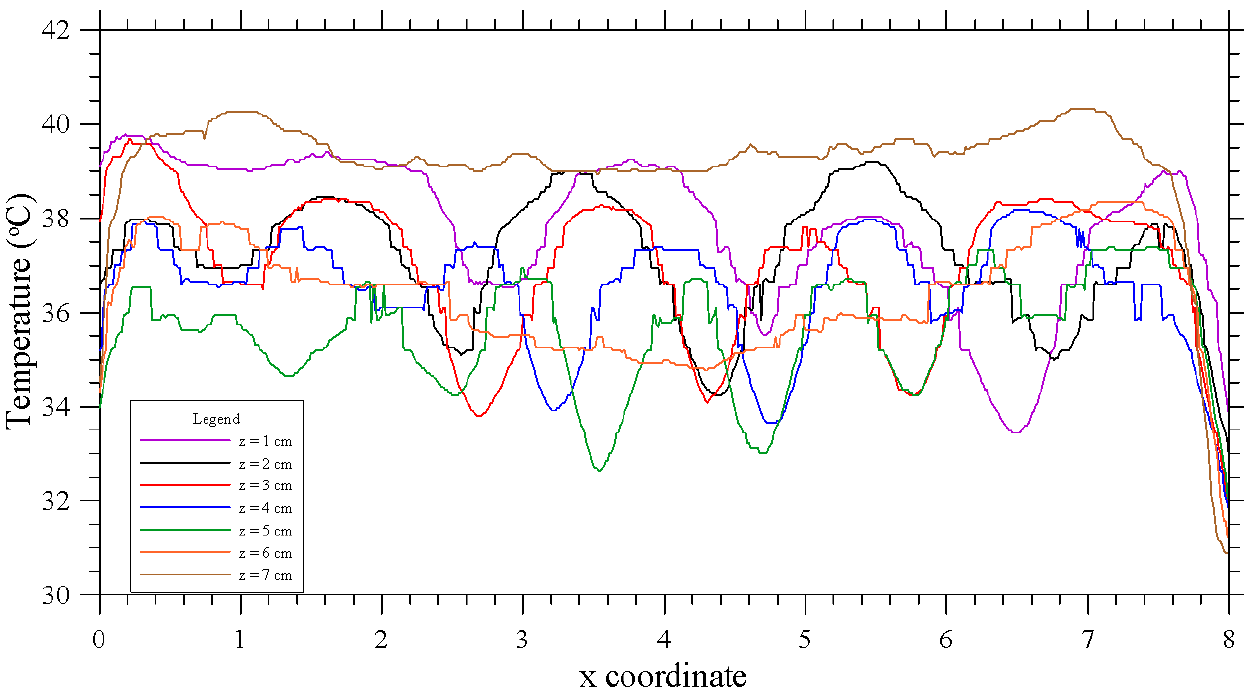
Figure 10. Profiles of temperature at different stations along the longitudinal direction z (square container, A = 16, d = 0.50 cm, Bo dyn ≅ 0.86, ∆ T = 27°C, ϑ ≅ 5°).